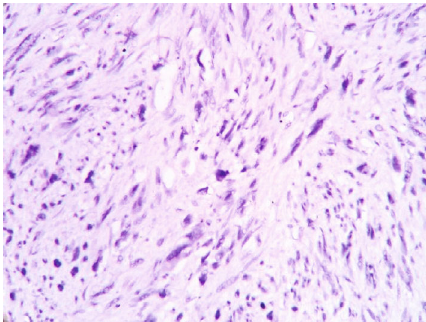
Figure 8: Poorly di ff erentiated malignant mesenchymal tumor. Immunohistochemistry assay with SMA antibodies. Positive reaction in tumor cells observed.